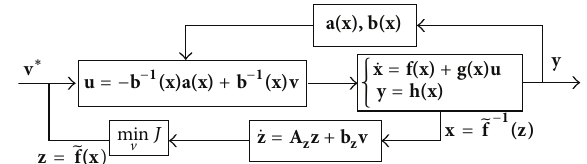
Figure 2: General principle diagram of Feedback linearization